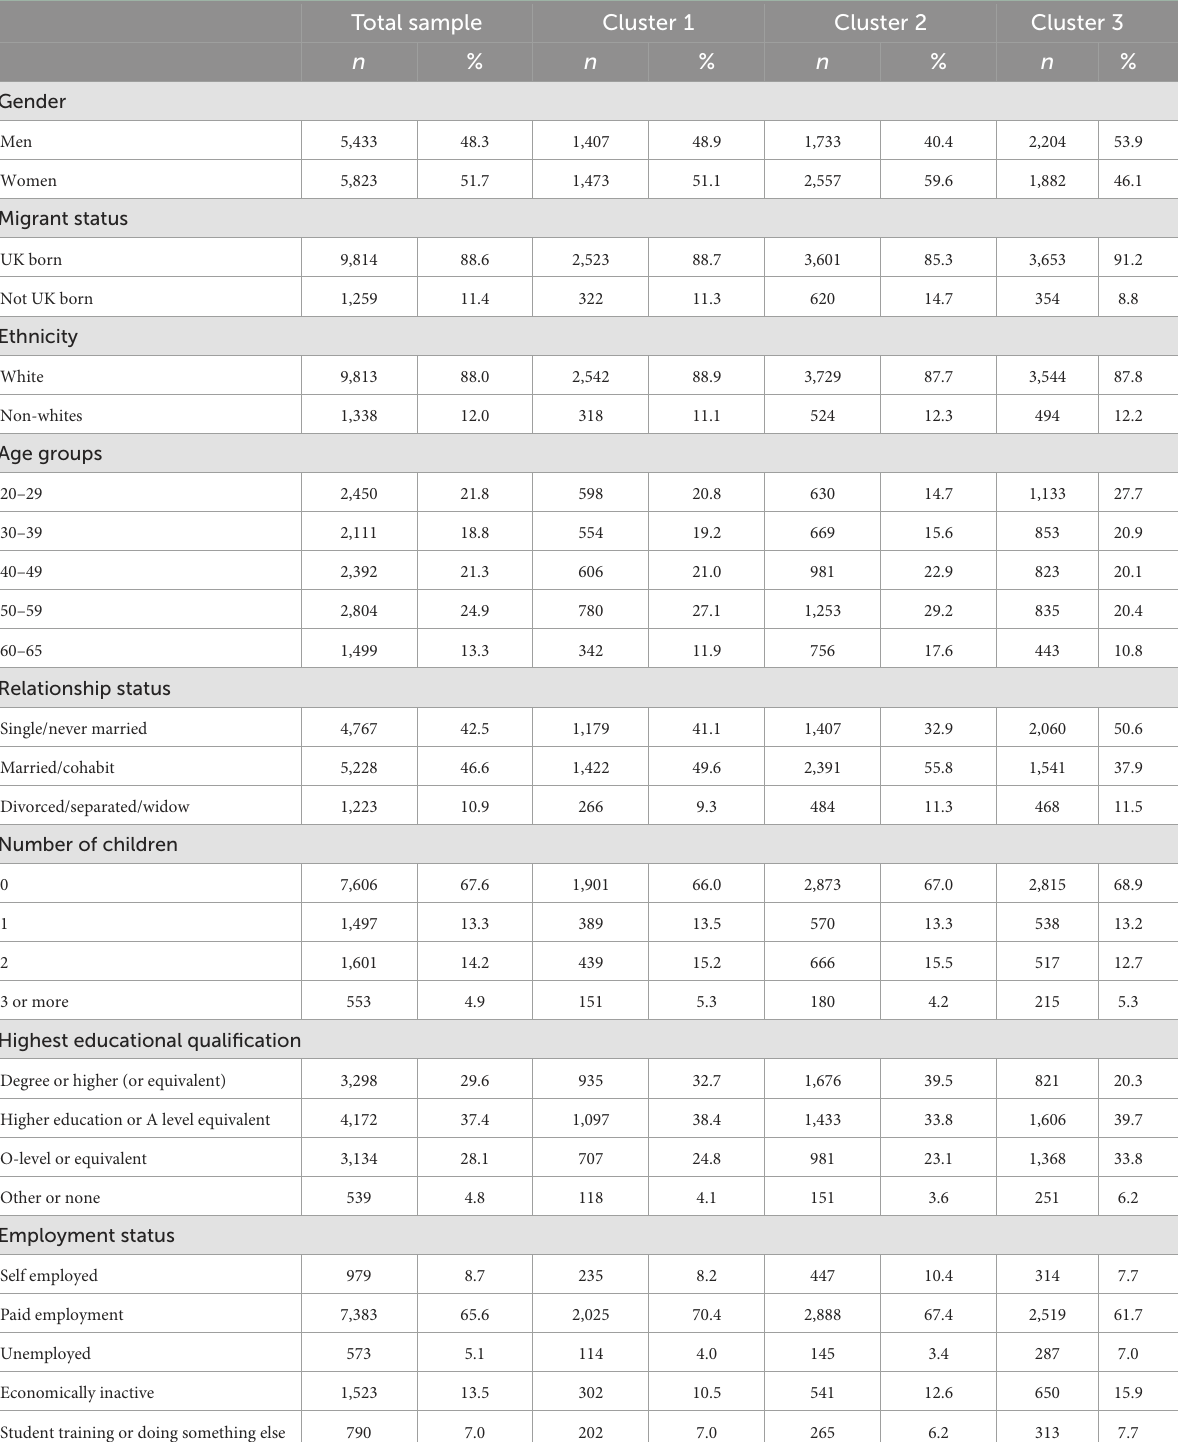
TABLE 1 Baseline characteristics of total sample and across the identified latent health behavioral clusters (cross-sectional